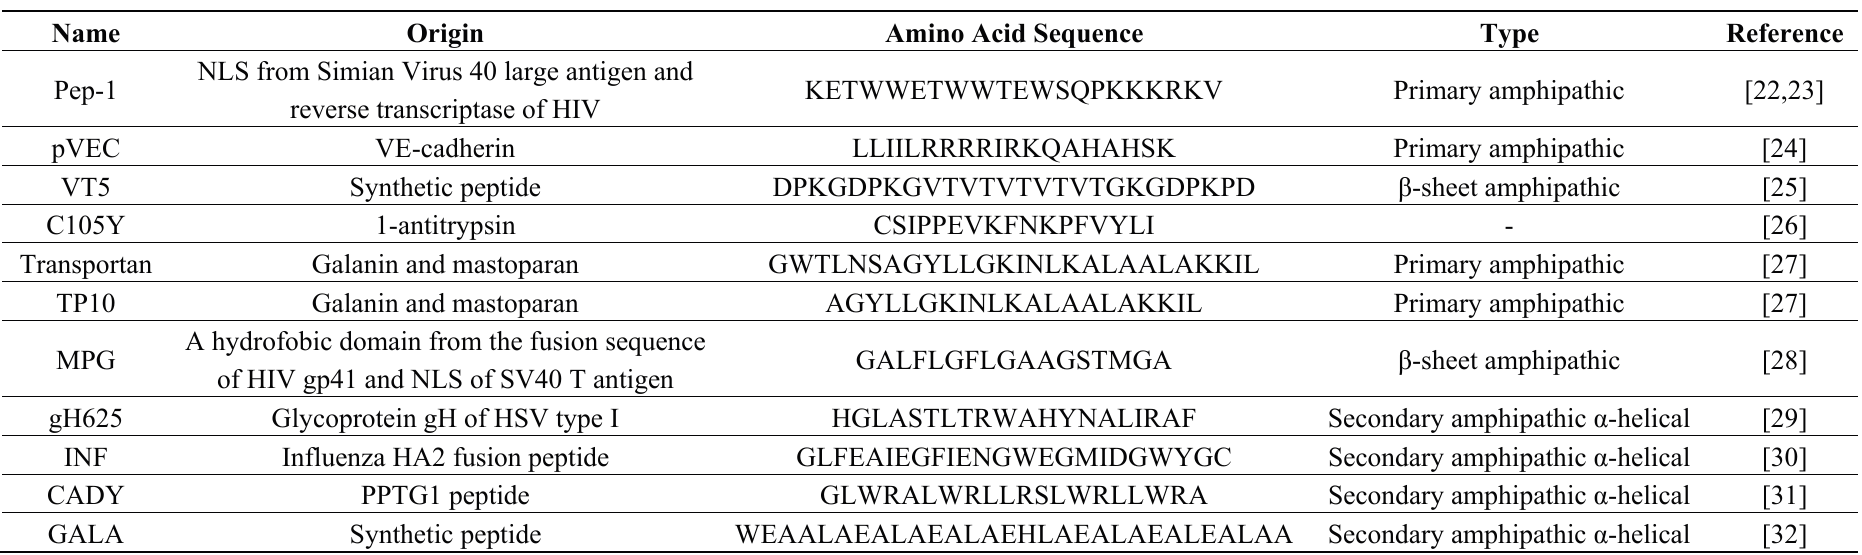
Table 1. Examples of membranotropic peptides used in drug